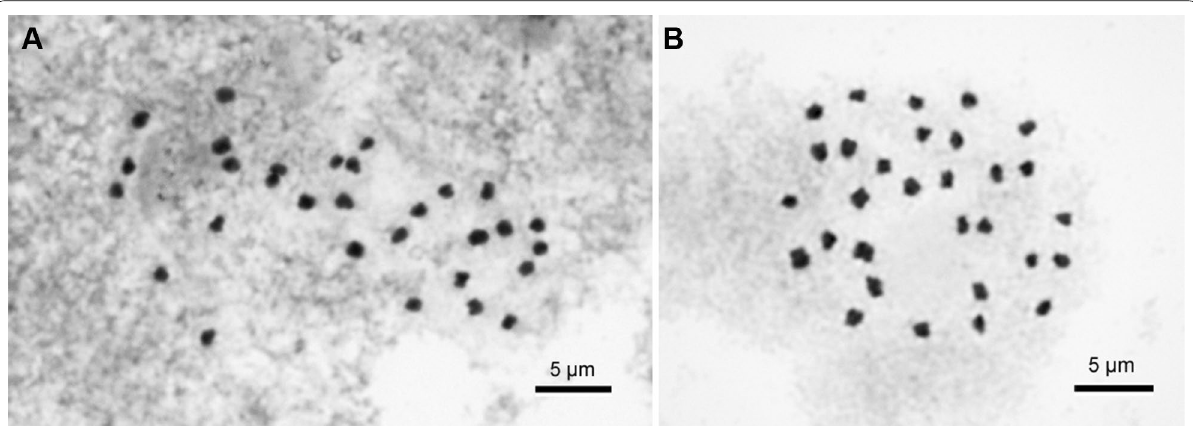
Fig. 9 Somatic chromosomes at metaphase. A Begonia longiornithophylla (2 n from C. ‑ I Peng et al. 20737 , HAST). Scale bars